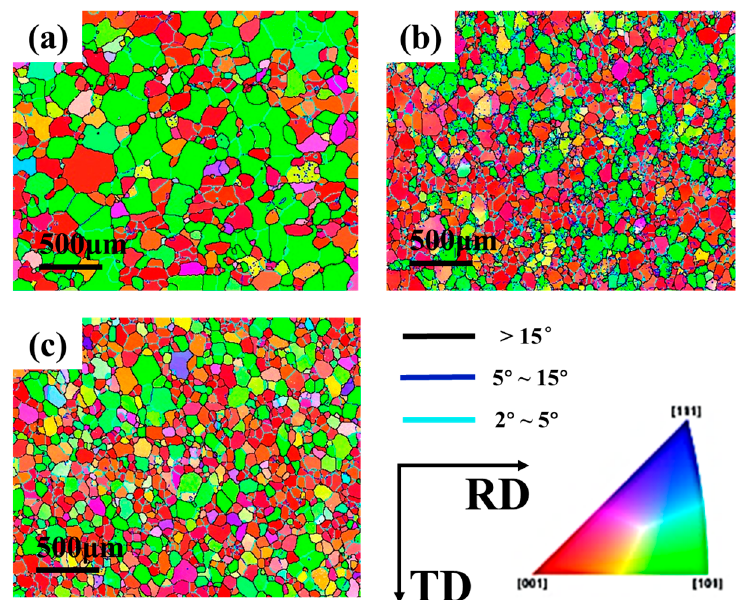
Figure 8. Microstructure morphology of tubes under different pressure: ( a ) original; ( b ) 1 MPa; ( c ) 1.5 MPa.